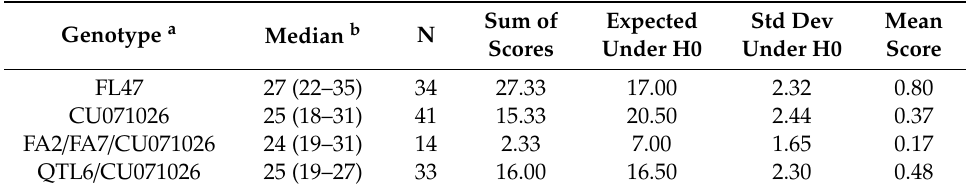
Table 3. Whiteflies’ developmental time from egg to adult eclosion in a non-acylsugar hybrid in relation to acylsugar-producing